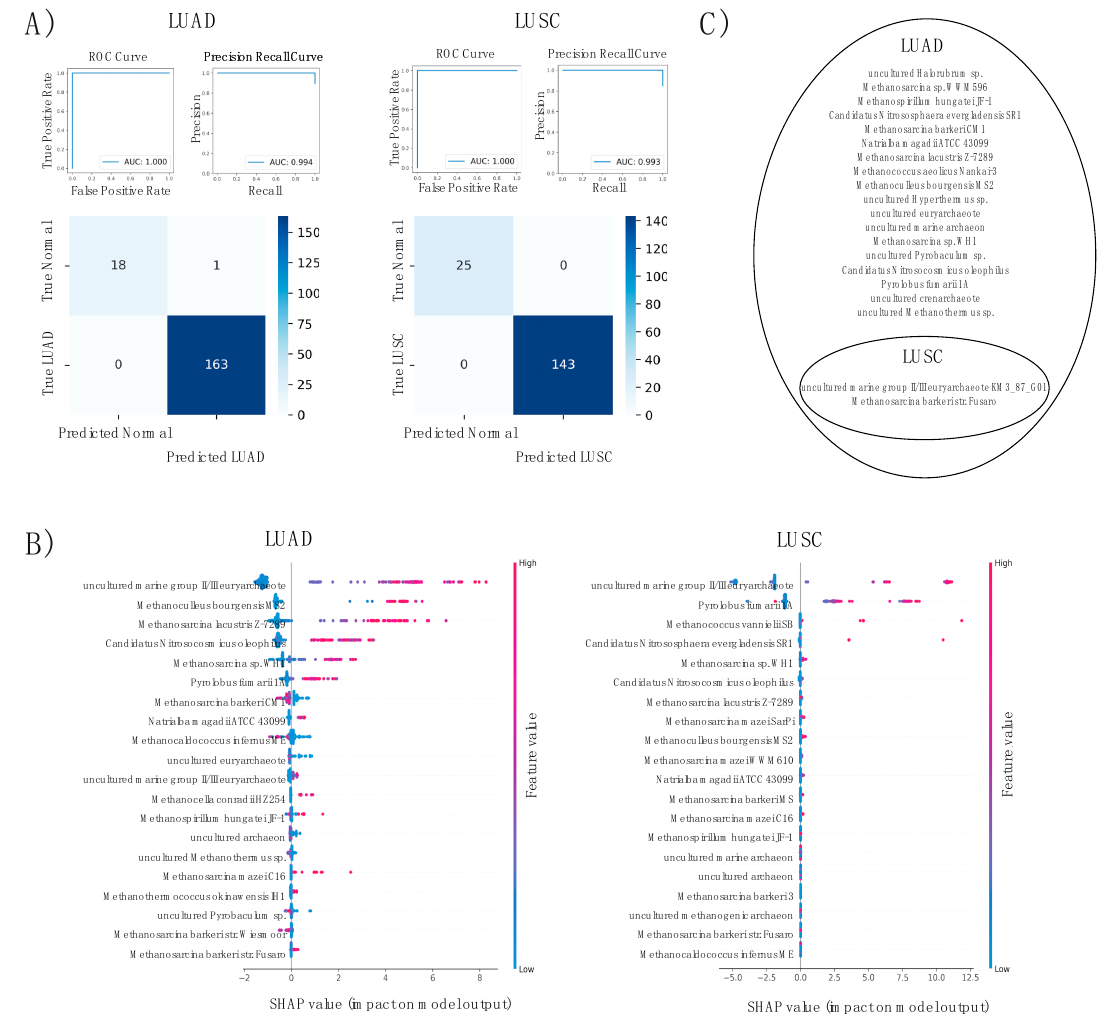
Figure 7. Machine learning classification of LUAD and LUSC. ( A ) ROC, precision recall curve and confusion matrix. Classifiers of the largest AUC, with values between 0 and 1, exhibit the greatest predictive accuracy. ( B ) SHAP values breakdown of two trained models. Features of the largest SHAP values are of greatest influence to the models’ predictive means. ( C ) Remaining features after RFE by cancer type. Most significant species to model prediction succeeding elimination.